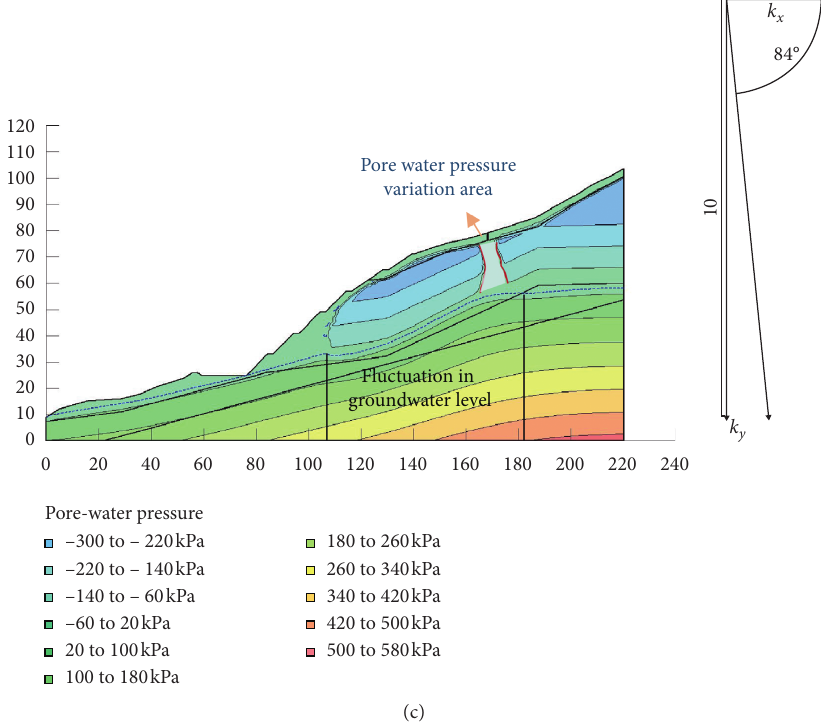
Figure 13: Pore water pressure contour of the cracking slope with permeability ratio as (a) 0.1; (b)1.0; (c) 10 after rainfall.